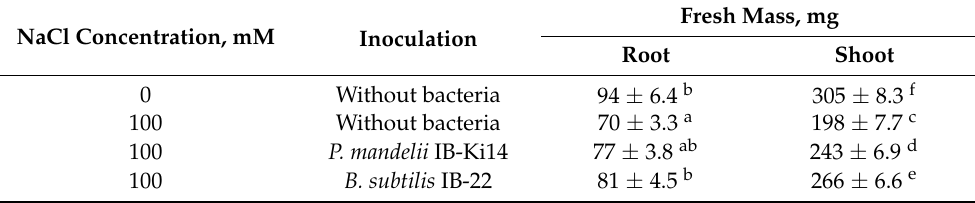
Fresh Mass, mg Root Shoot